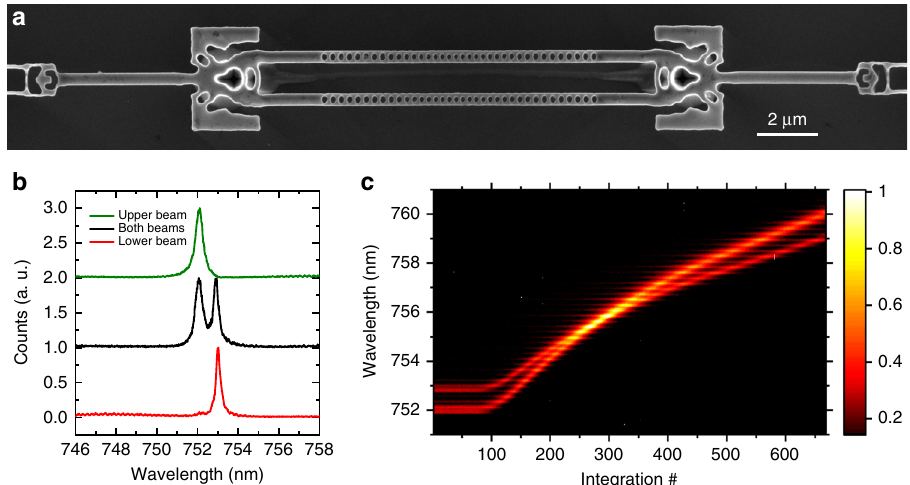
Fig. 4 Interfacing grating couplers with a diamond photonic circuit. a Diamond photonic circuit, which could be used to entangle two emitters inside the two cavities. The circuit consists of a grating coupler, followed by a waveguide-splitter, and two resonators, the outputs of which are then recombined in a waveguide-splitter and coupled off-chip through a grating coupler. b Spectra of the nanobeams from the device shown in a . Green, black, and red data correspond to the upper, both and the lower nanobeam, respectively. c Demonstration that cavities with fabrication induced frequency offset can be tuned in resonance via gas tuning; colorbar corresponds to normalized counts